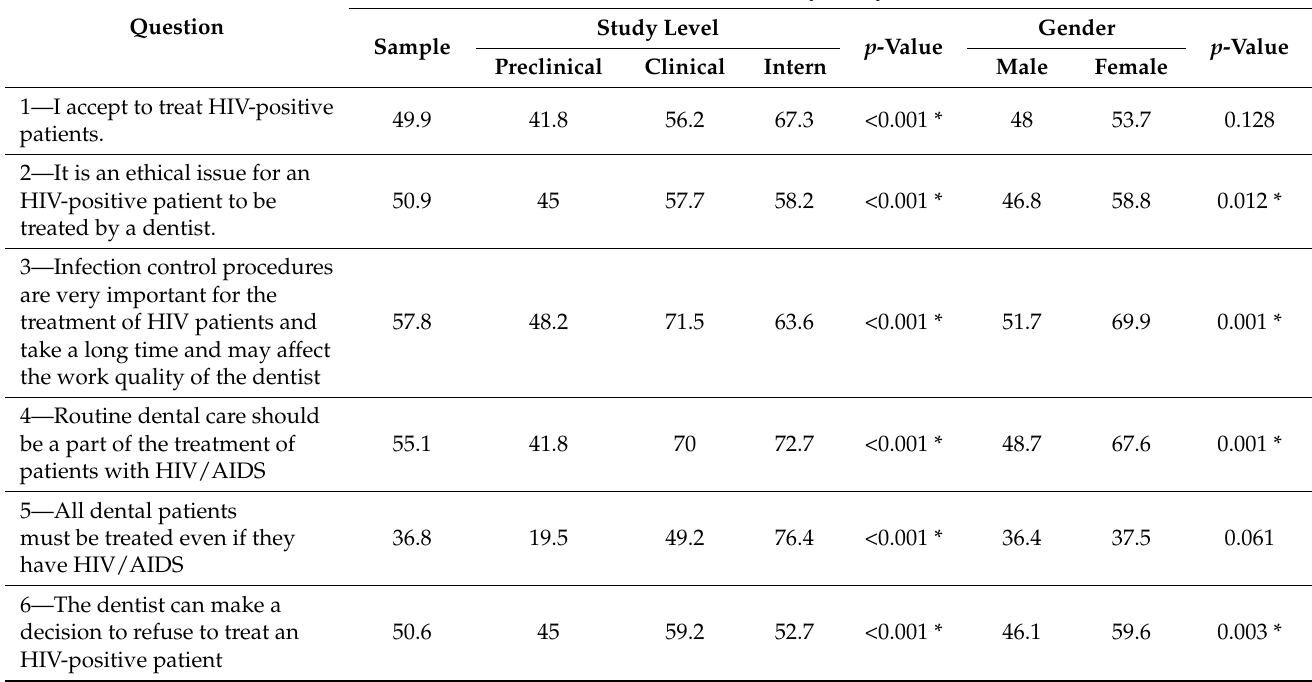
Table 3. Response of participants to attitude-related questions regarding treatment of HIV patients by gender and study level (no = 405).